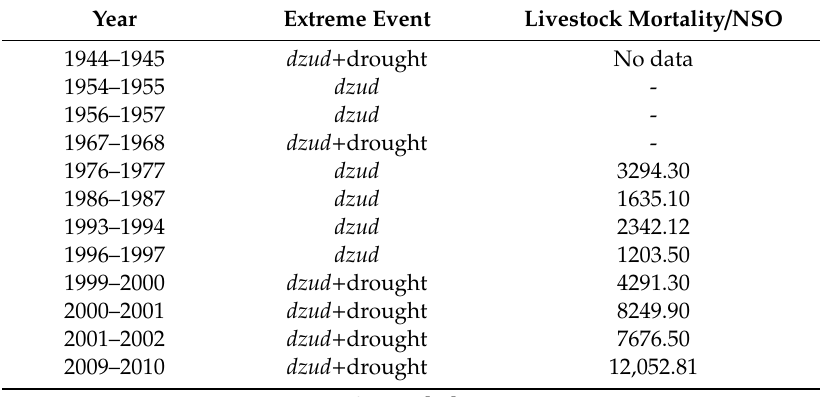
Table A1. The Dzud events on the Mongolian plateau in the past 70 years.